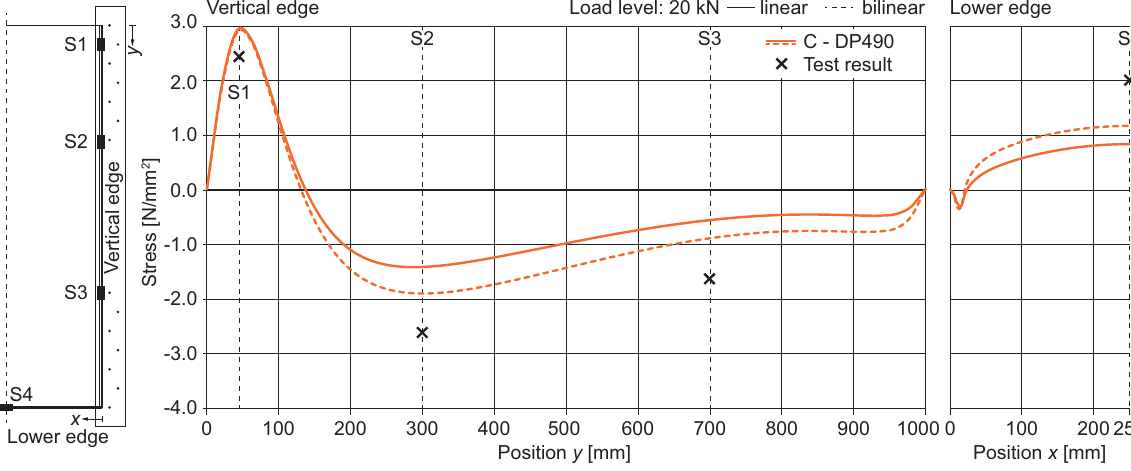
The best coincidence between calclulation and experiments is achieved for the flexible silicone adhesive. All strain gauges record strains which match perfectly to the computed stress distribution (Fig. 13). This applies also to nolax C44.8505 (Fig. 14) at the strain gauge positions S1 and S4. But, the numerical simulation leads to higher